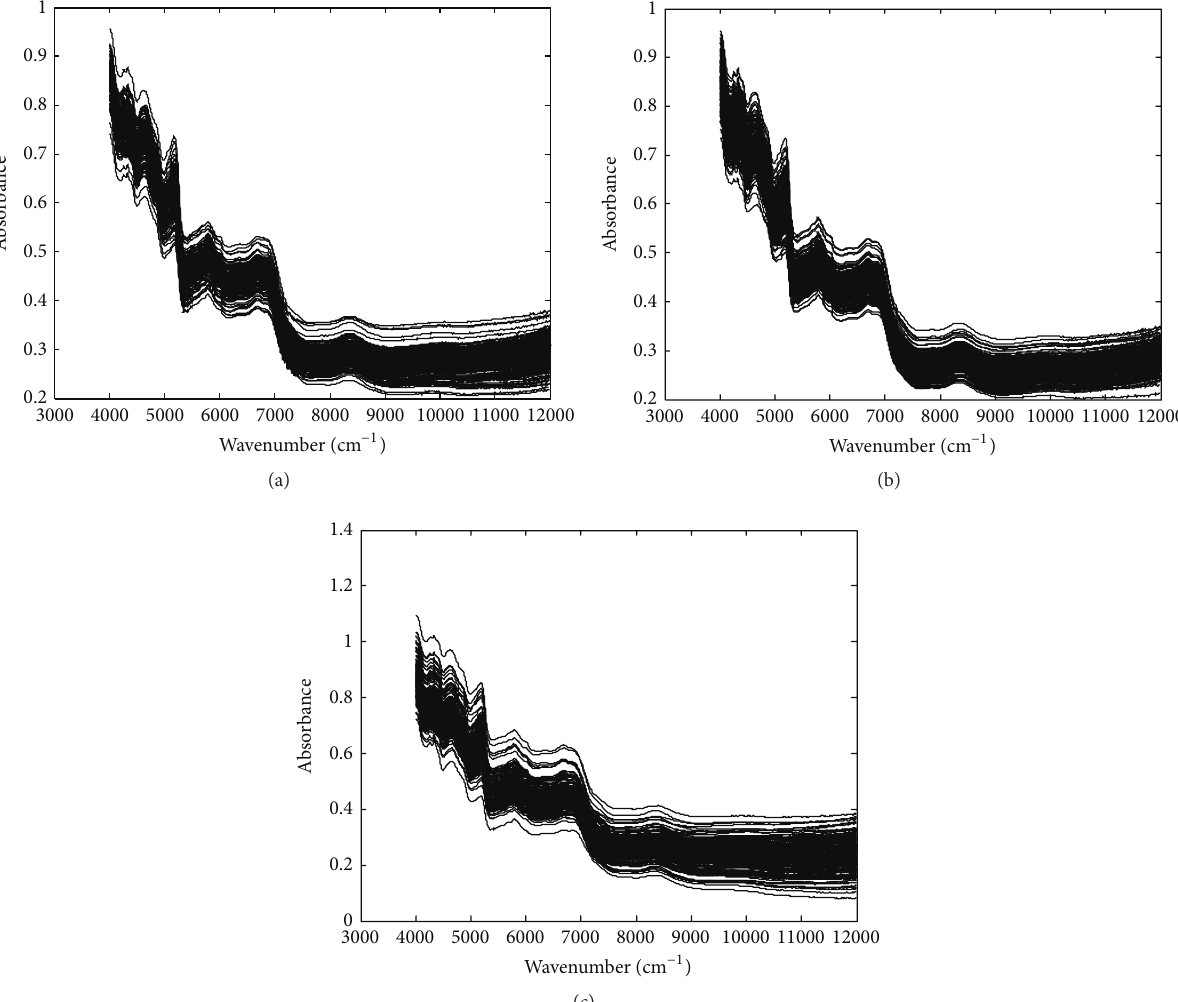
Figure 1: Representative raw NIR spectra of Longjing tea of grade I (a), grade II (b), and grade III